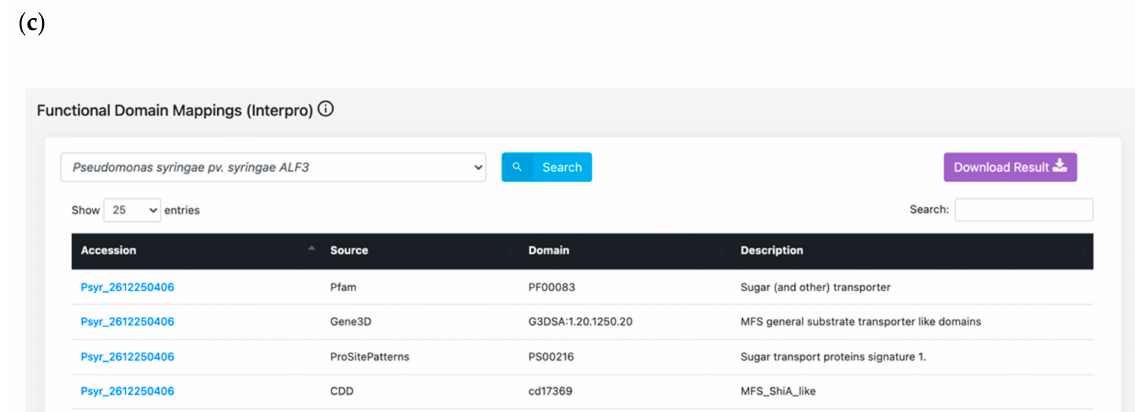
Figure 4. Examples of annotation modules of alfaNET: ( a ) protein annotations; ( b ) subcellular localizations; ( c ) functional domain